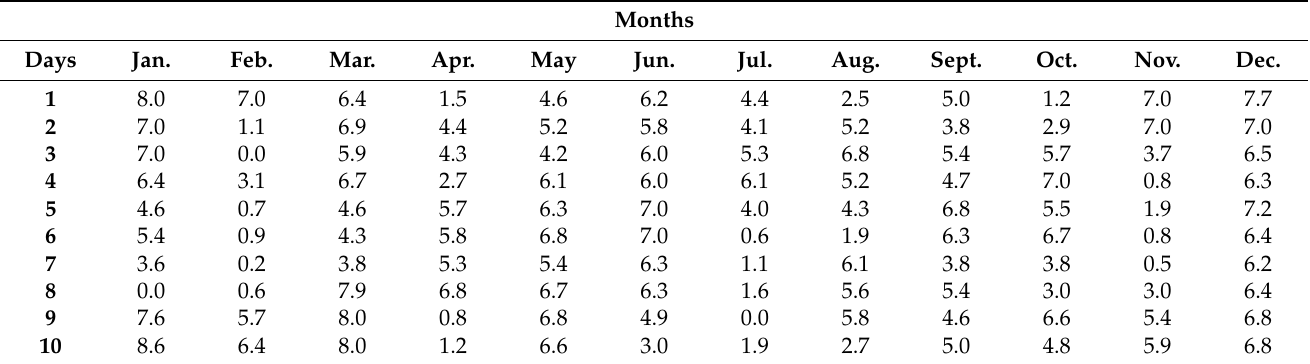
Table 3. An example of daily average cloudiness from meteorological data in the Turkish State Meteorological Service (the numbers indicate rate of average